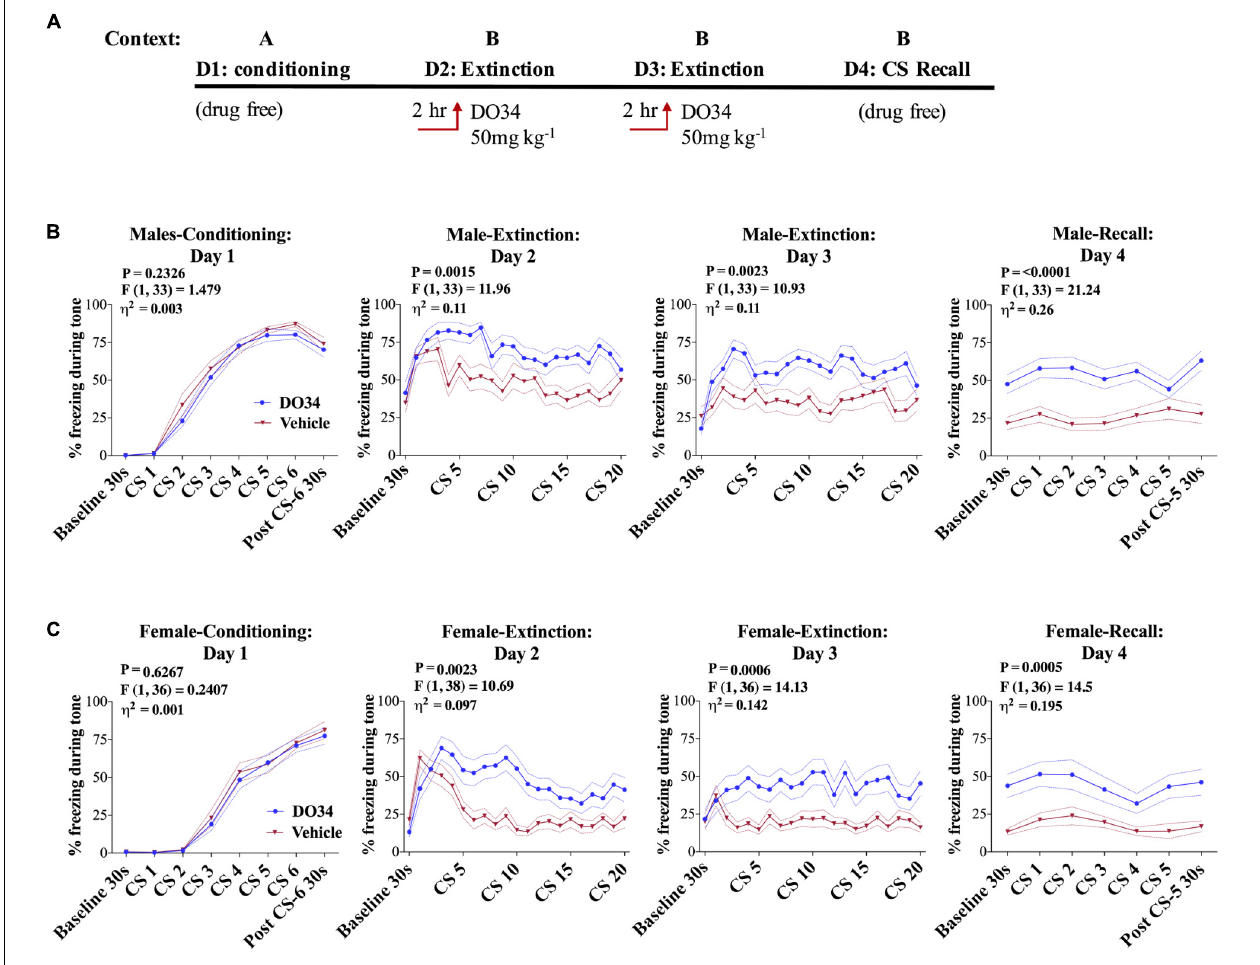
FIGURE 3 | Pharmacological DAGL inhibition impairs fear extinction. (A) Schematic diagram of the experimental paradigm. (B) (Far left panel) % freezing by C57BL/6J male mice during acquisition of cue-conditioned fear. (Middle panels) % freezing during auditory cue by mice during extinction training days 2 and 3 when D034 (50 mg kg − 1 ) was injected IP 2 h prior to trial. (Far right panel) % freezing during extinction recall ( n = 17 DO34-treated male mice, n = 18 vehicle-treated male mice). (C) (Far left panel) % freezing by C57BL/6J female mice during acquisition of cue-conditioned fear when DO34 (50 mg kg − 1 ) was injected IP 2 h prior to trial. (Middle panels) % freezing during auditory cue during extinction training days 2 and 3. (Far right panel) % freezing during extinction recall ( n = 18 DO34-treated female mice n = 20 vehicle-treated female mice). F - and P -values and η 2 for main effects of drug treatment shown in each panel. All values are presented as mean ±